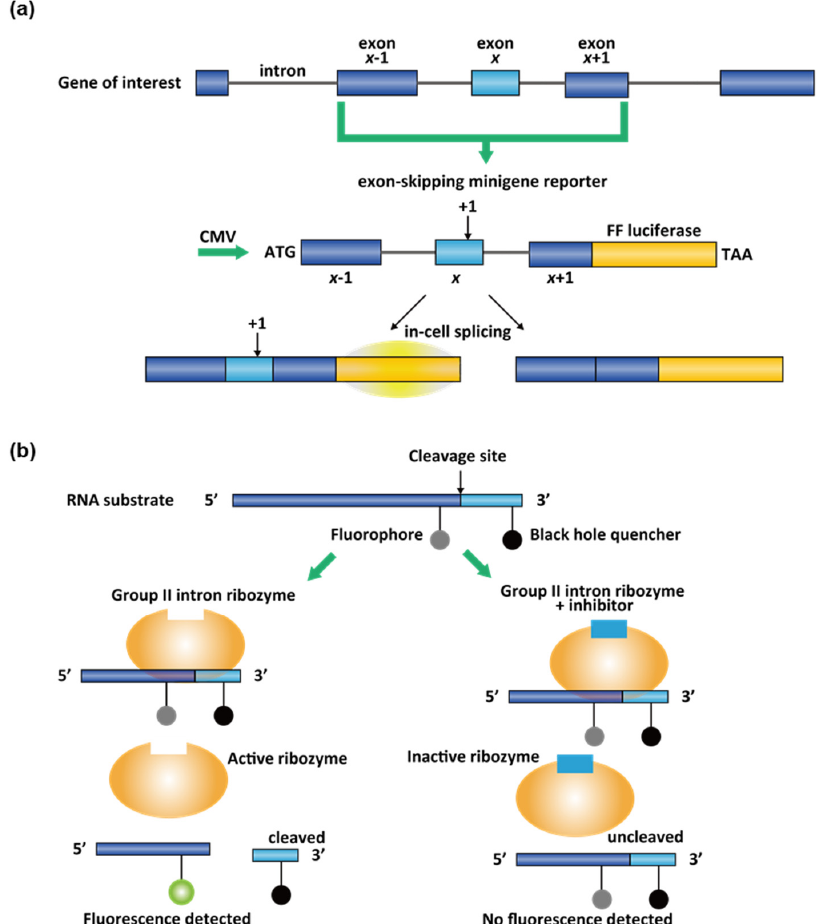
Figure 10. ( a ) Design of a minigene reporter assay for spliceosome-dependent splicing. By single- point addition, the firefly (FF) luciferase at the 3 ′ -end will only be in-frame when exon x is included. ( b ) Design of in vitro FRET assay for group II intron splicing.